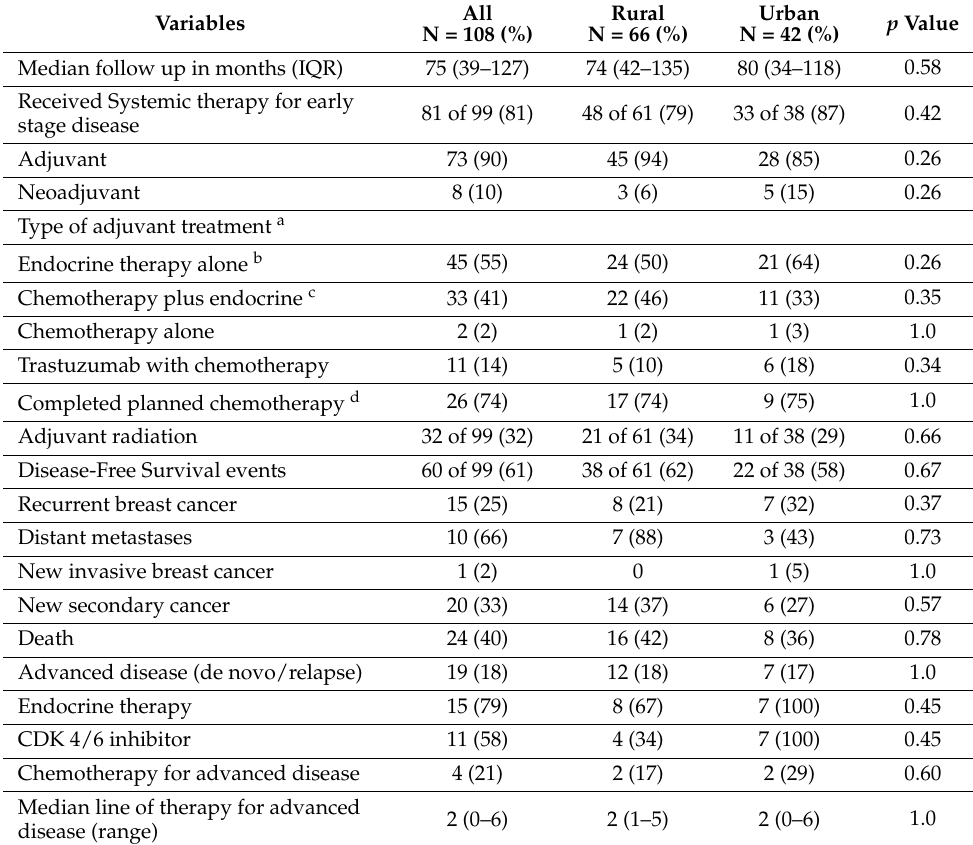
Table 2. Interventions and outcomes of the entire cohort and the two